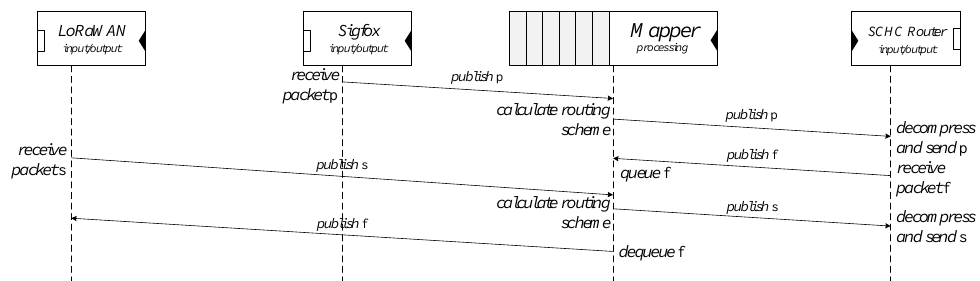
Figure 6. Mobility and queue management in a FLINT system. This diagram shows how packets travel through a FLINT system configuration. Time moves downwards. The central element is a Mapper adapter. Packets are distributed from transmitting devices to the destination. Packets in the downward direction are queued and dequeued according to the device’s interfaceType .